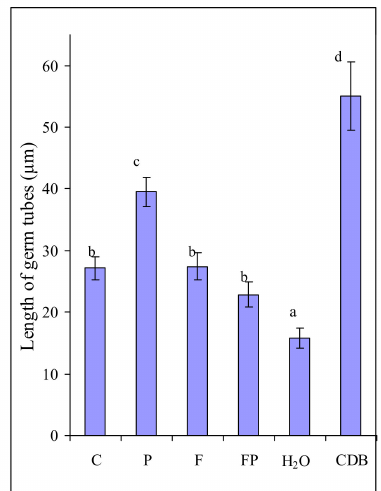
Figure 2. Length of germ tubes of Fusarium culmorum macroconidia after 6 h of incubation in solutions of exudates of control barley (C), barley colonized by P. fluorescens (P), barley colonized by F. culmorum (F) and barley colonized by both P. fluorescens and F. culmorum (FP), in sterile water (H 2 O), in liquid medium (CDB). Data are presented as the mean from two experiments. n = 300 macroconidia. Error bars show standard deviation. Values of di ff erent letters are significantly di ff erent at p ≤ 0.05 when applying Fisher’s LSD test.